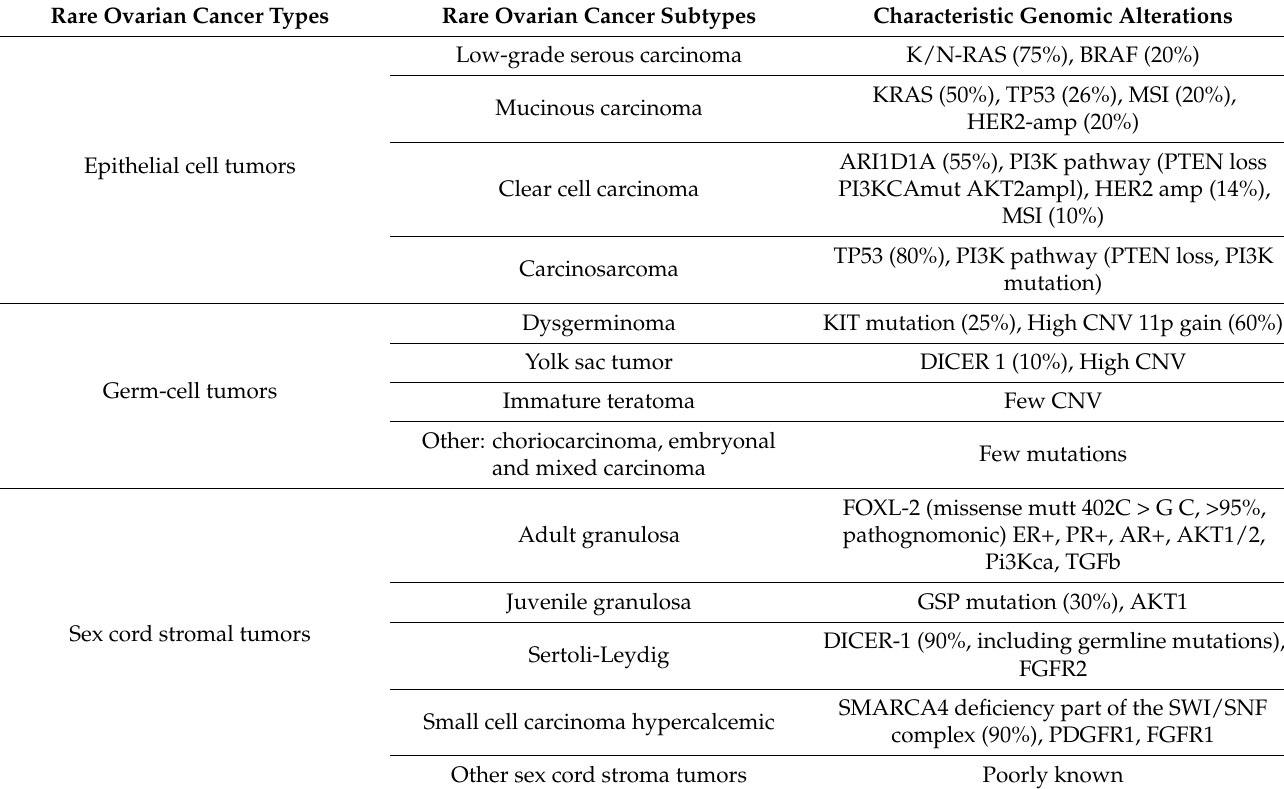
Table 2. A compilation of genomic alterations identified in rare ovarian cancers. Rare Ovarian Cancer Types Rare Ovarian Cancer